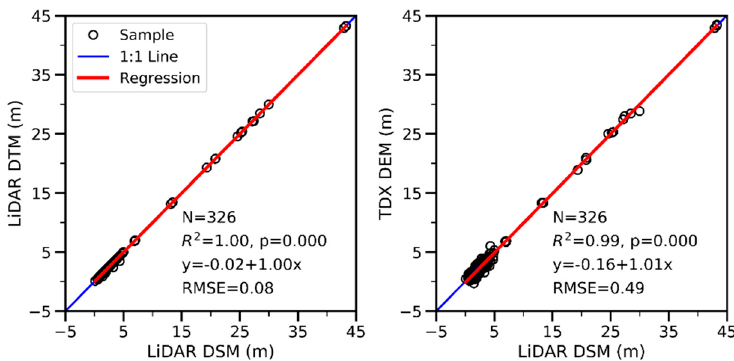
Figure 6. From left to right, linear regressions of LiDAR DTM versus LiDAR DSM elevations and TDX DEM versus LiDAR DSM elevations.